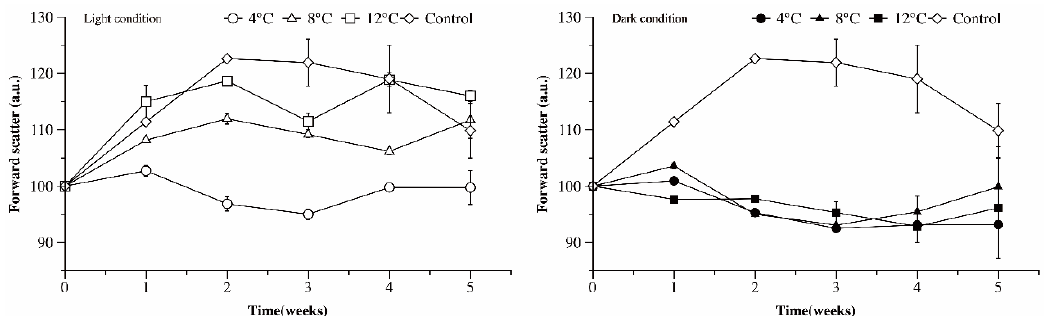
Figure 6. Forward scatter, analyzed by FCM, of Ma cells exposed to different temperature and light conditions as a function of time.